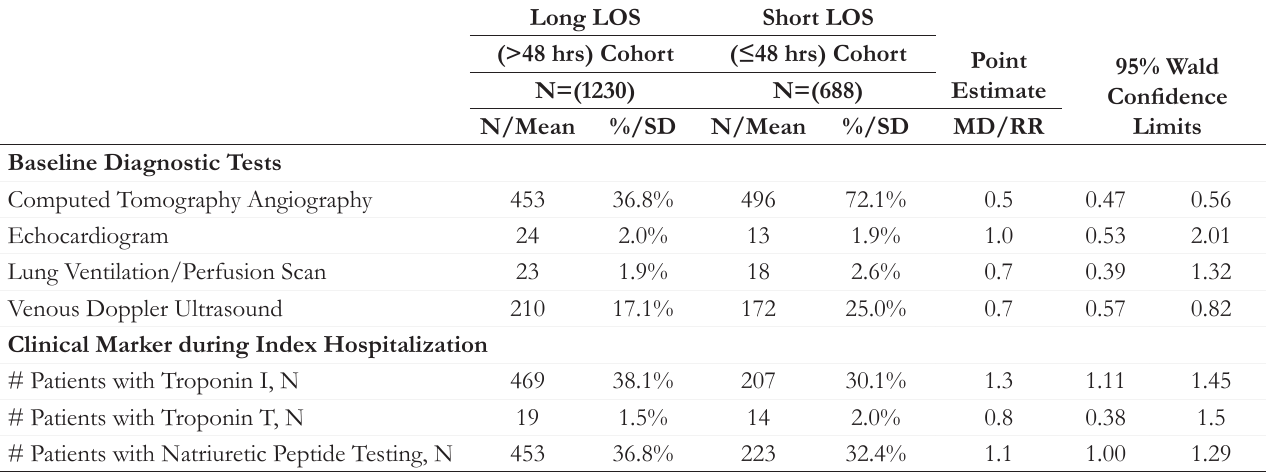
Table 1. Baseline Demographic and Clinical Characteristics of LRPE Patients with Long versus Short LOS - Continued